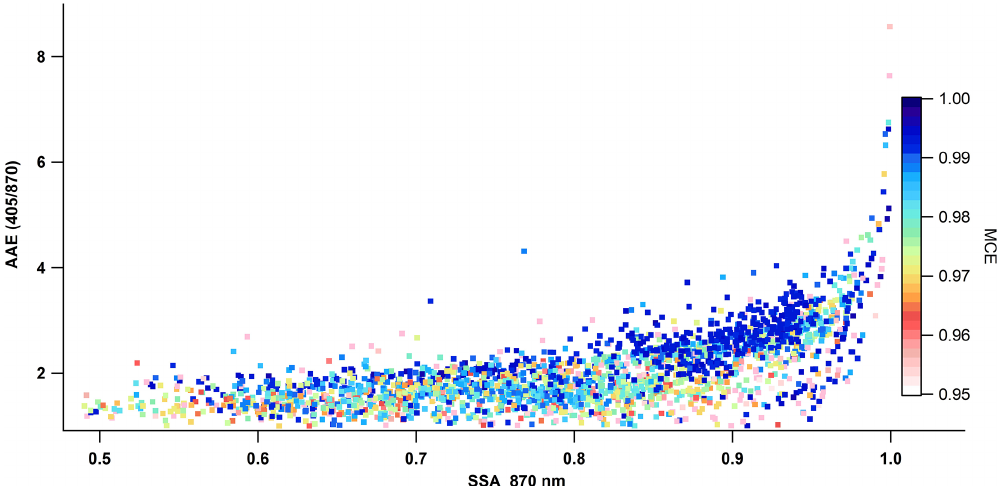
Figure 6. The AAE calculated at 405 and 870nm vs. SSA at 870nm for the zigzag kiln measured every second during emissions collection. Each data point is colored by MCE. This deviates from the typical trend in that the highest MCEs are not clustered at the lowest SSA or AAEs. Some BrC is emitted at a variety of “higher”